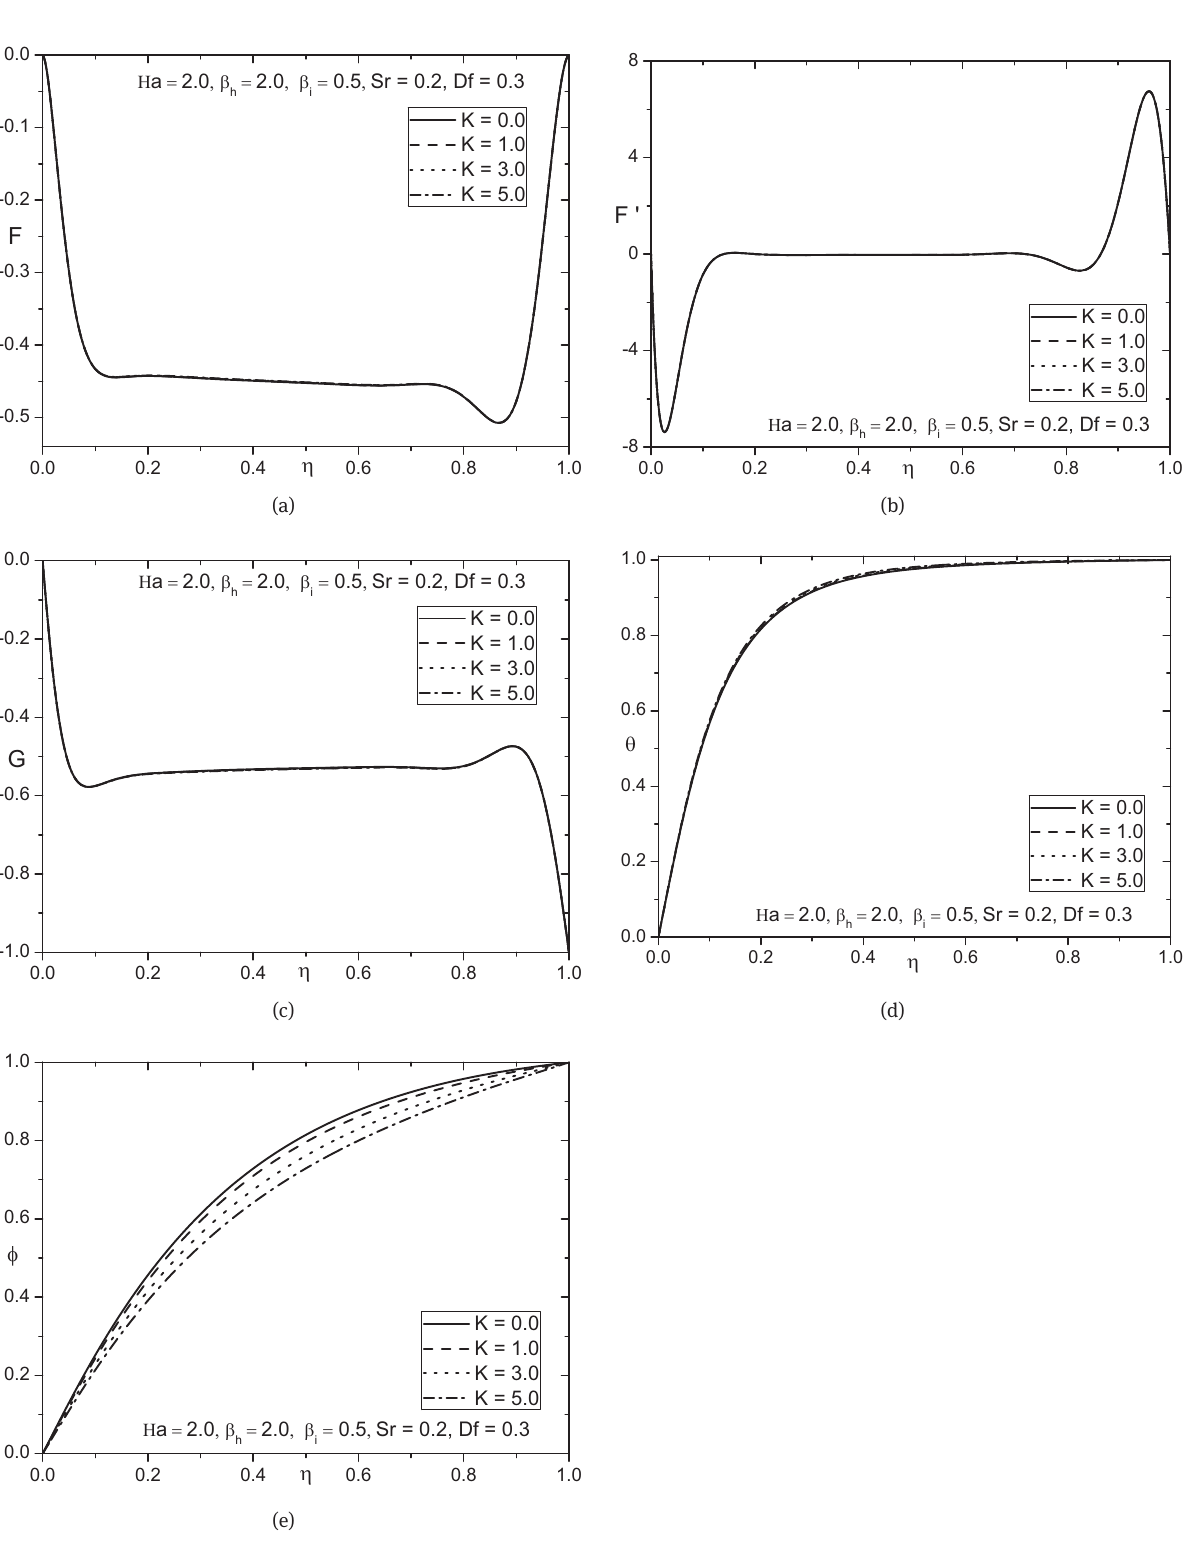
Fig. 5: Effect of chemical reaction parameter on (a) axial velocity, (b) radial velocity, (c) tangential velocity, (d) temperature, and (e) concen- tration